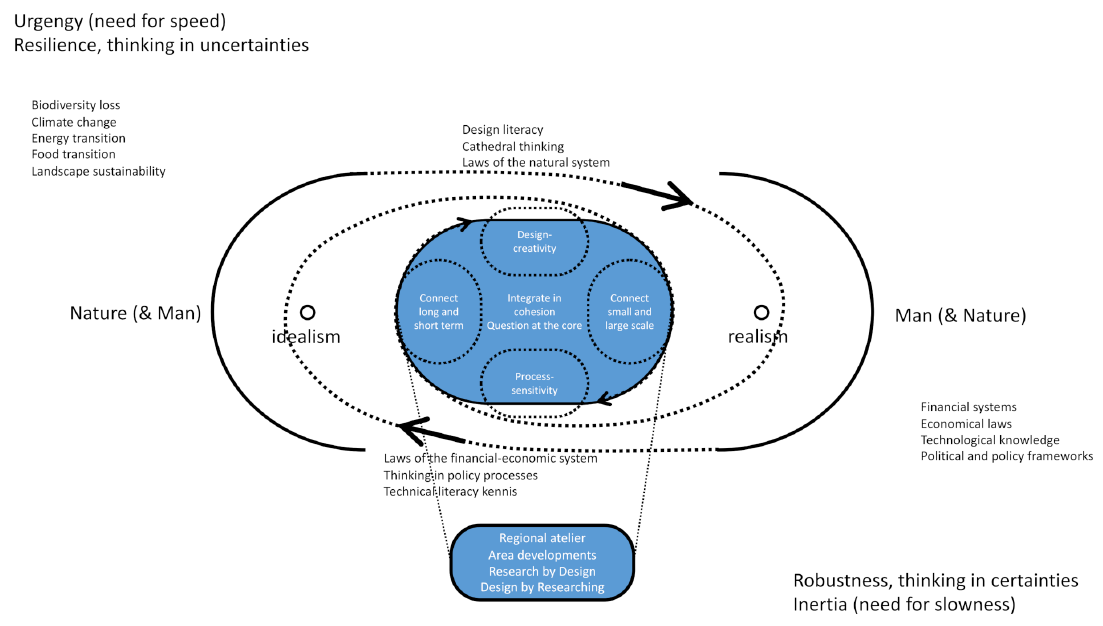
Figure 4. Reconnecting urgency and robustness